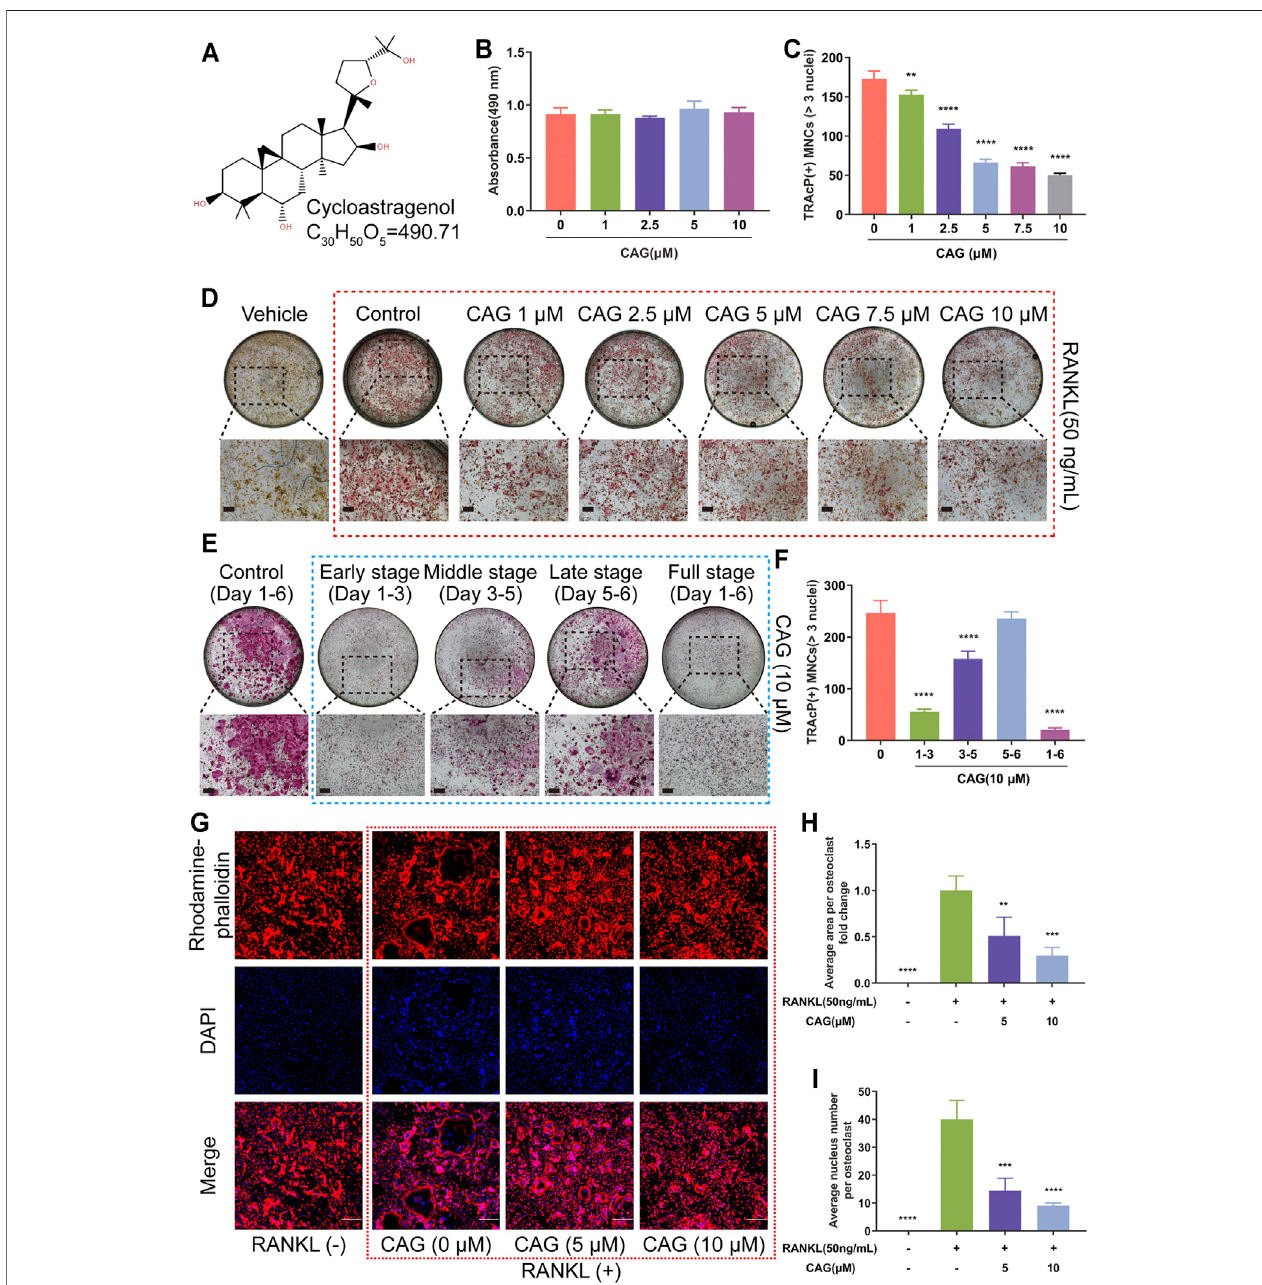
FIGURE 1 | CAG inhibits osteoclastogenesis and osteoclastic F-actin belt formation triggered by RANKL in BMMs. (A) The structural formula and molecular formula of CAG. (B) MTS test demonstrated that the proliferation of BMMs was not affected by different concentrations of CAG for up to 48 h. (C) Quantitative analysis exhibited that the rise of CAG concentration resulted in the decline of osteoclast count. (D) Typical TRAcP staining images of osteoclasts formed by BMMs after being treated with 1, 2.5, 5, 7.5, and 10 µM of CAG for 6 days. (E) Quantitative analysis indicated that CAG administration on days 1 – 3 and 3 – 5 reduced the osteoclast count on day 6. (F) Typical TRAcP staining images of osteoclasts formed by CAG-treated BMMs on days 1 – 3, days 3 – 5, days 5 – 6, and days 1 – 6. (G) Typical immunostaining images of F-actin rings (red belts) and nuclei (blue dots) formed by BMMs after treating them with 5 and 10 µM of CAG for 6 days. (H – I) Quantitative analysis unveiled that the gradual decrease in the area by F-actin and the number of nuclei were correlated with the increase in CAG concentration. The largest osteoclasts in each group were selected to count nuclear numbers. n (cid:1) 32 (CAG 0 µM), 18 (CAG 5 µM), and 19 (CAG 10 µM) (n (cid:1) osteoclasts numbers). Data of all histograms are displayed as mean (SD). n (cid:1) 3. ** p < 0.01, *** p < 0.001. **** p < 0.0001. Scale bar (cid:1) 200 µM. BMMs: bone marrow monocytes; CAG: cycloastragenol; DAPI: 4 ′ ,6-diamidino-2-phenylindole; MNCs: multinucleated cells; MTS: cell proliferation assay; RANKL: receptor activator of nuclear factor κ B ligand; TRAcP: tartrate- resistant acid